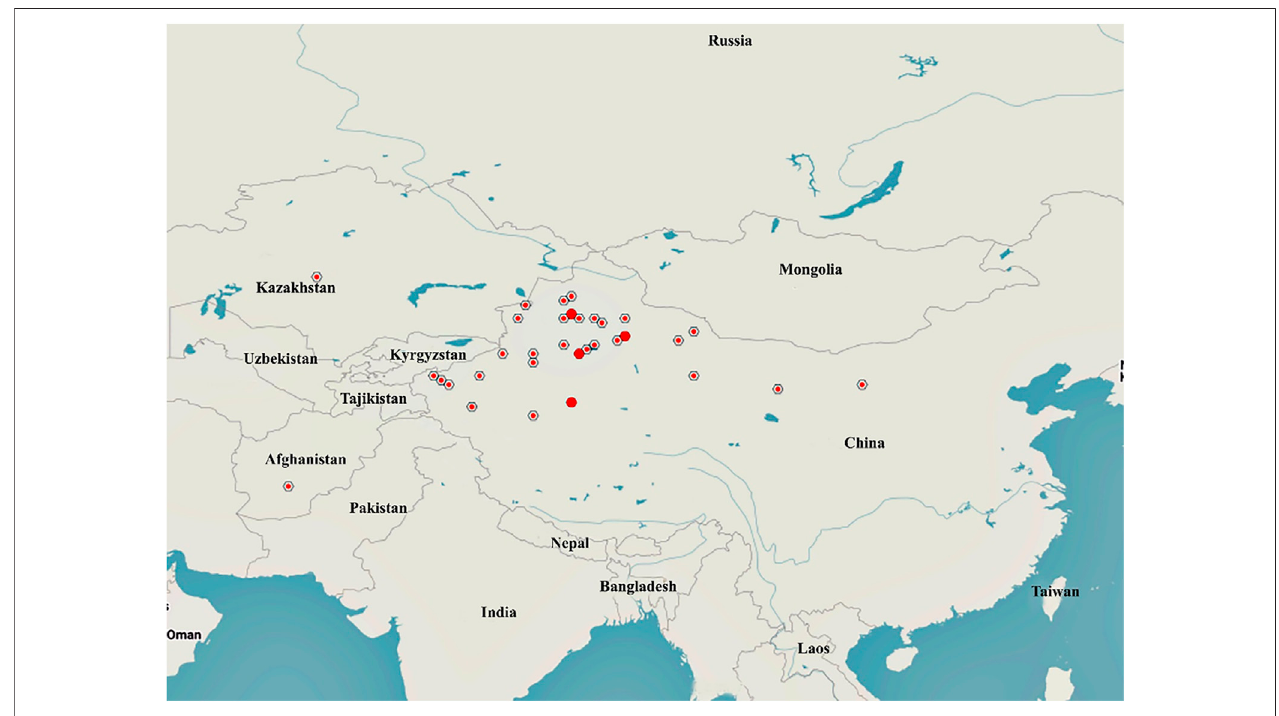
FIGURE 2 | Distribution of A. sparsifolia in different countries and regions (https://www.gbif.org/species/2945088).